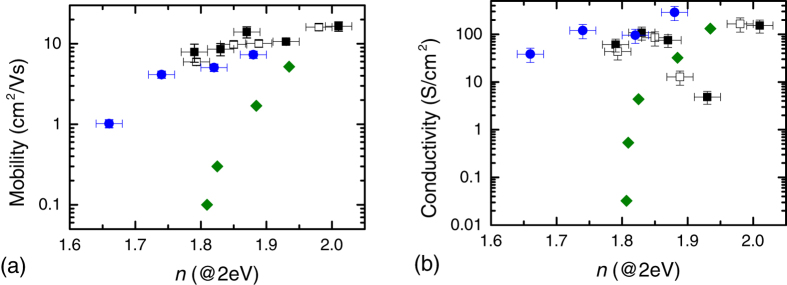
Mobility vs. n of the deposited Superlattices.Modulation in the (a) mobility and (b) conductivity of the superlattices plotted against their refractive index at hν = 2 eV (λ = 620 nm). Results for cation substituted Zn1−xMgxO:Al are included for comparison. (■) a-IGZO/SiOx superlattices on glass substrate, (□) a-IGZO/SiOx superlattices on Al2O3, () ZnO:Al/SiOx superlattices, () Zn1−xMgxO:Al grown by spray pyrolysis from Fleischer et al.7.